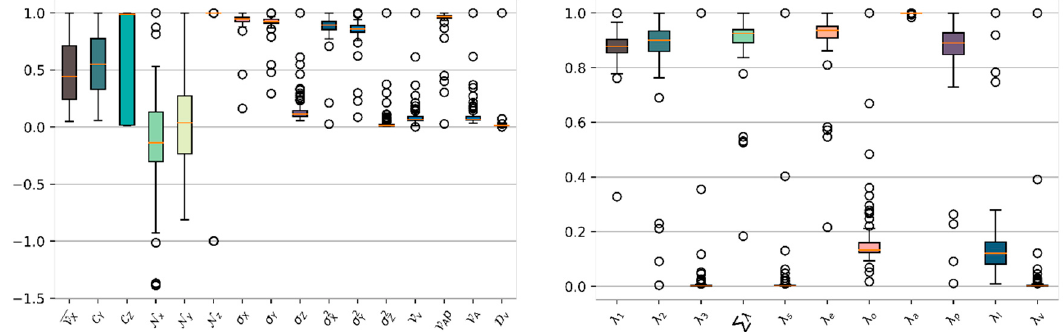
Figure 6: Box plot of primary elements feature variation. Figure 6. Box plot of primary elements feature variation.